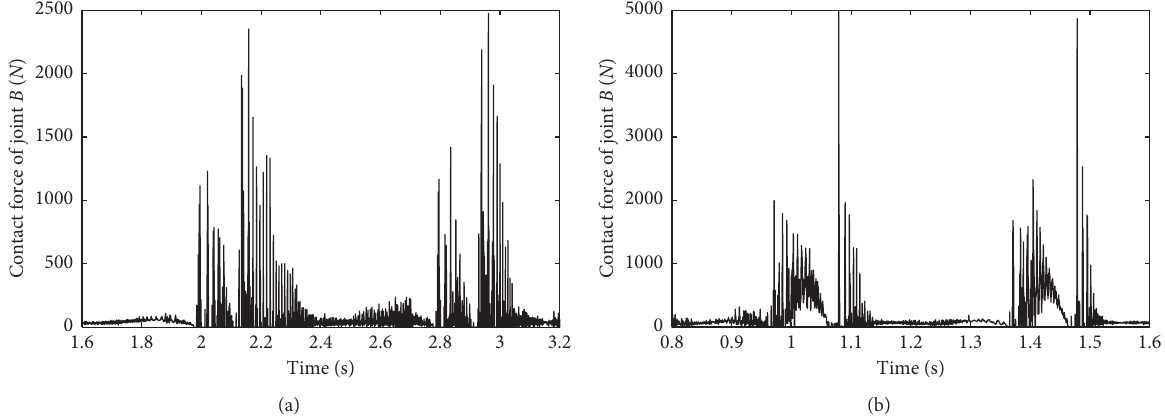
Figure 20: Contact force at pair B. (a) ω